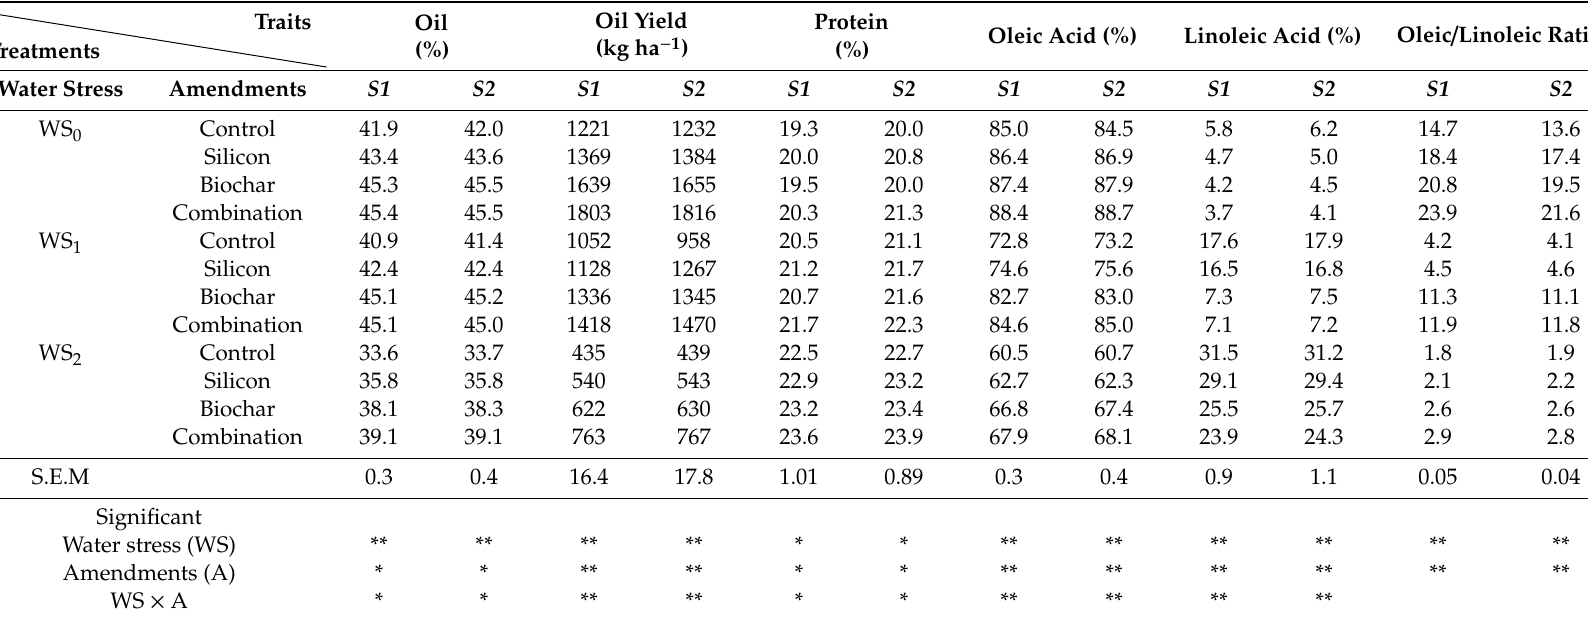
Table 5. Interaction e ff ects of soil and foliar amendments and water deficit stress treatments on oil traits and fatty acids of sunflower during two growing seasons 2016 and 2017. Traits Treatments Water